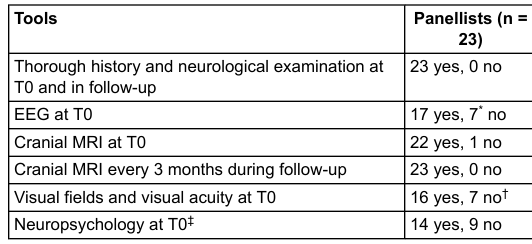
Table 1: Tools proposed to assess “fitness-to-drive”. Tools Panellists (n =